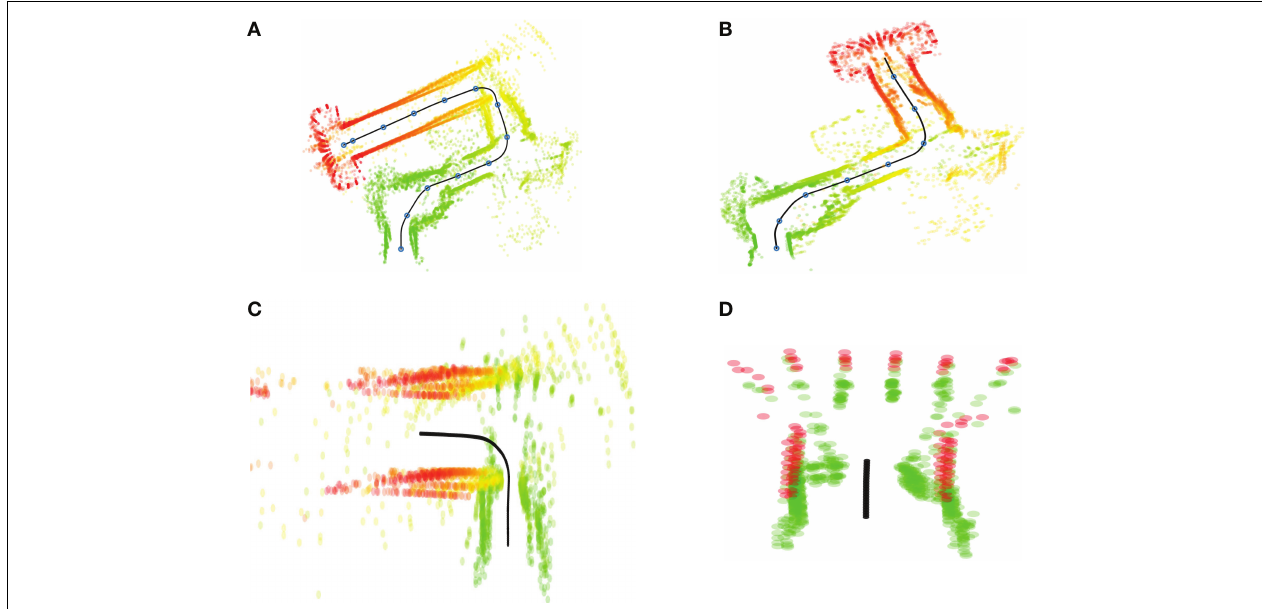
FIGURE 11 | Typical runs from condition Bed–Elevator . (A) Laser scans in relation to the path, executed overtly from bed (green) to the elevator (red). Blue circles along the path, represented by the black line, mark 2.5-s intervals. (B) Corresponding laser scans generated in covert mode. (C) Magnification of selected period (14–20s) from the overt condition. (D) Corresponding (15–17s) magnification from covert condition. See text for details.